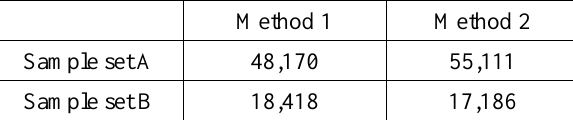
Table 2. Comparison between DE-based detectors re-editing method and random detectors generation approach. Method 1: DE-based detectors re-editing method (numbers of DE iterations used). Method 2: Random detectors generation approach (numbers of random detectors